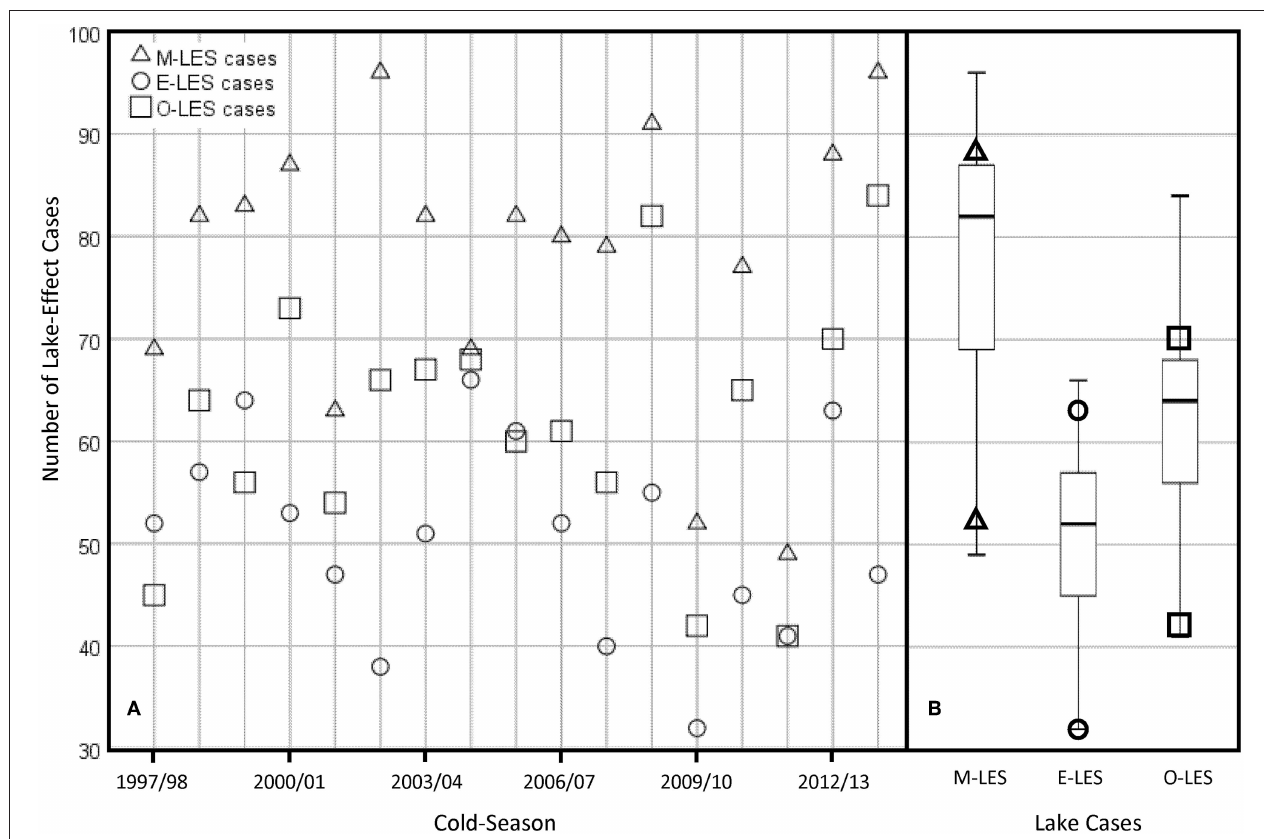
FIGURE 1 | The annual variation (A) and distribution attributes (B) of the number of LES days for the 17 cold seasons from Laird et al. (2017) in the Lake Michigan (M-LES; triangles), Lake Erie (E-LES; circles), and Lake Ontario (O-LES; squares) regions. The number of LES days for cold seasons of 2009/2010 and 2012/2013 are identified on the box-plots in panel (B) using symbols within the lowest and highest quartiles,